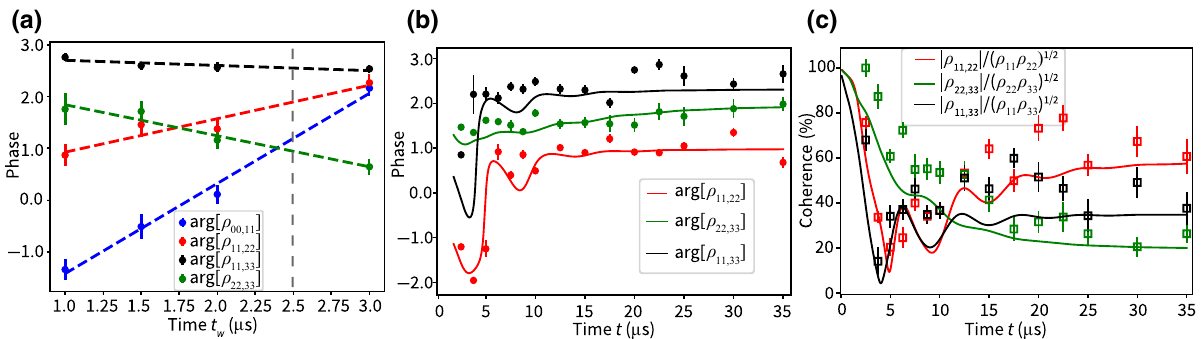
FIG. 6. The evolution of the pair-photon phases and coherence informed by subspace tomography. (a) Phases of selected off-diagonal elements of the two-cavity state ρ M , measured with the d = 2 subspace tomography, as a function of the wait time t w after state preparation with the stabilizing drives for t = 15 µ s. The phase evolution agrees with the cavity Kerr terms ˆ H sk and the cavity detuning in the drive frame. The dashed lines are linear fits, which allow us to interpolate or extrapolate the phases of these states to different t w . The vertical dashed line corresponds to the time at which the density-matrix block is plotted in Fig. 4(j). In order to compare with Wigner data in Fig. 4, note that the effective free-evolution time of the two-cavity state here is t w + 2 µ s, accounting for the duration of the selective transmon | g (cid:2) - | e (cid:2) pulses in the subspace-tomography protocol [Fig. 5(a)]. (b),(c) The (b) phases and (c) relative coherence of selected off-diagonal density-matrix elements of the two-cavity state for different stabilization pumping times t , measured with subspace tomography after t w = 1 µ s. The solid lines show parameter-free numerical-simulation results of the storage pair-photon dynamics according to Eq. (8), which does not contain the reservoir mode and captures all prominent features of the data. The two-photon dissipation and drive rates used in the simulation are obtained from the fits in Fig.